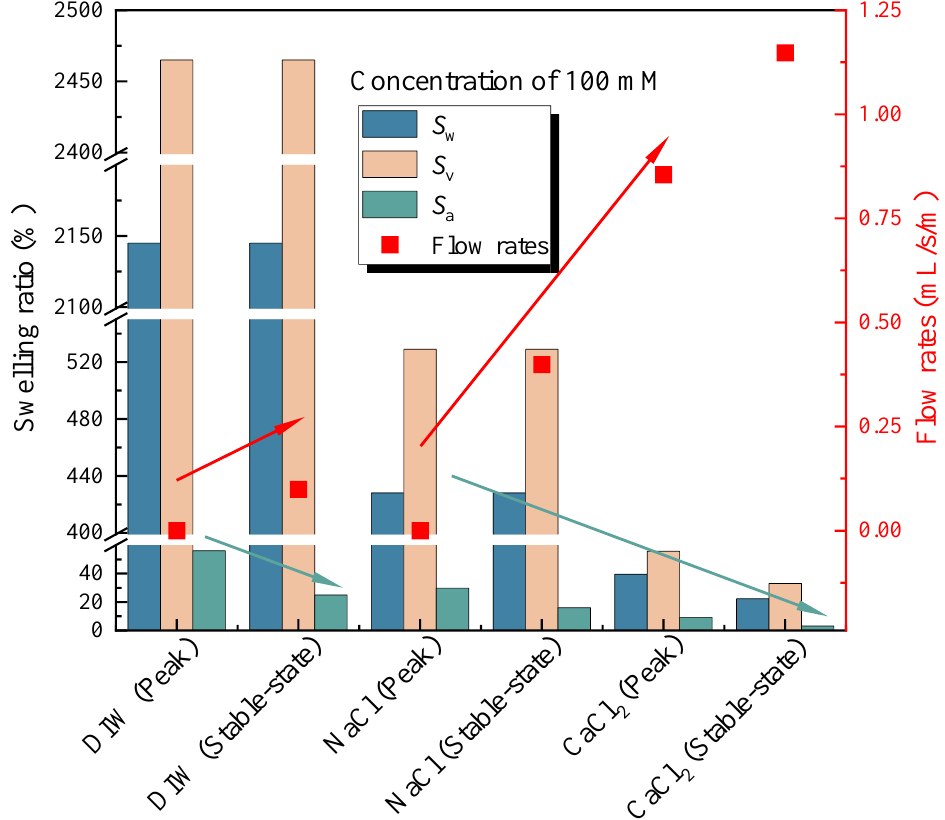
Figure 8. The relationship between the flow rates of the poor-sealing hydrophilic gaskets and the S w , S v , S a , and type of liquids.